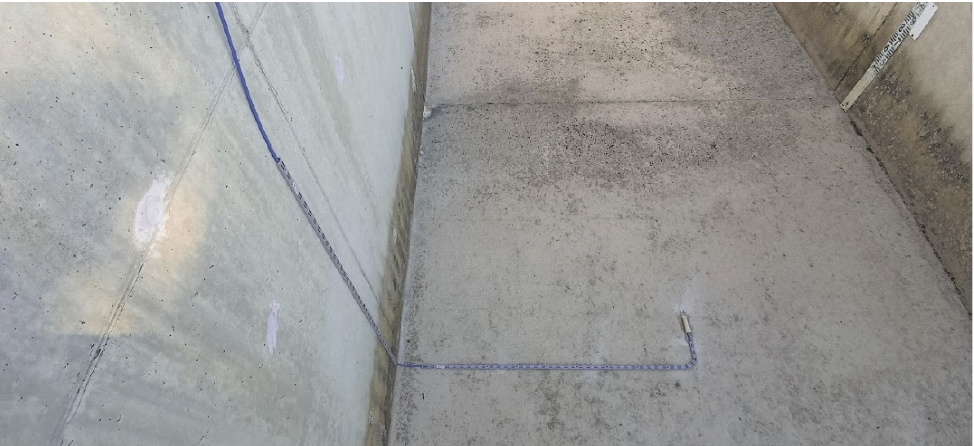
Figure 10. Picture of the sensor of the Nivus Portable Flowmeter installed in the centre of the auxiliary channel, upstream of the testing chute. channel, upstream of the testing